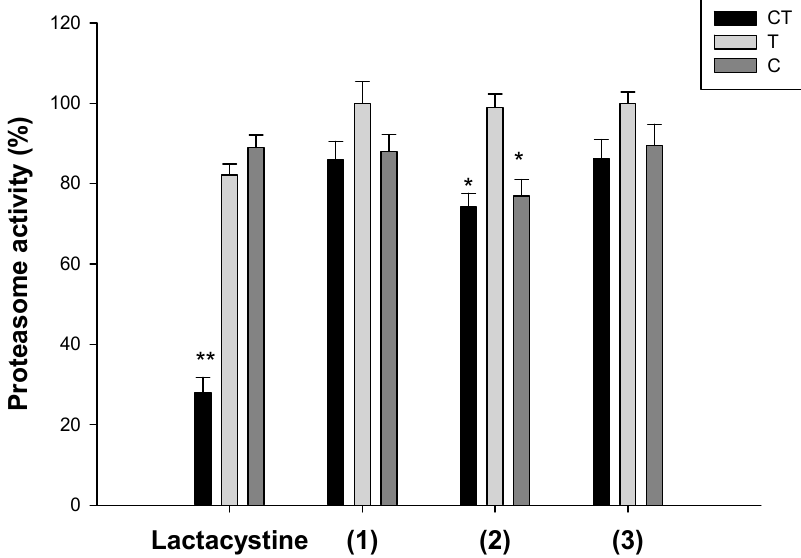
Figure 6. Proteasome inhibition. Inhibition of chymotrypsin-like (CT-L), trypsin-like (T-L), and caspase-like (C-L) activities of purified 20S proteasome was assessed fluorometrically after 60 min of incubation with increasing concentrations of compounds 1 – 3 or Lactacystin. * P < 0.1, ** P < 0.01 compared with control.